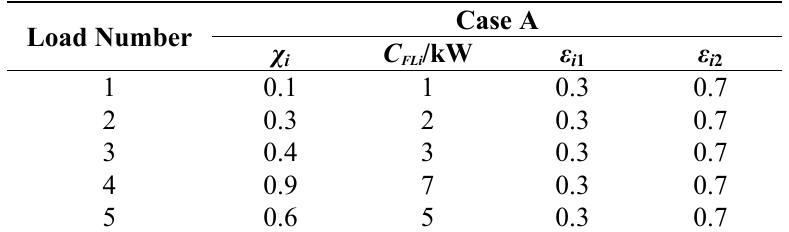
Table 1. Parameters of loads in Case A.